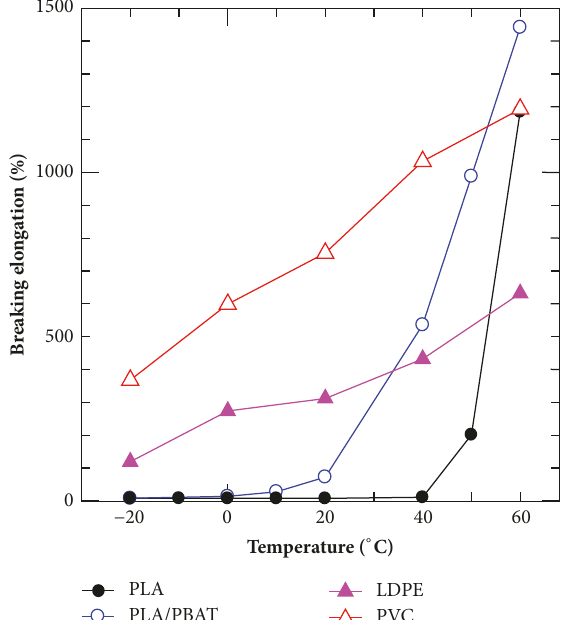
Figure 6: Tensile strengths at break of PLA and PLA/PBAT. Figure 7: Breaking elongation of PLA and PLA/PBAT.